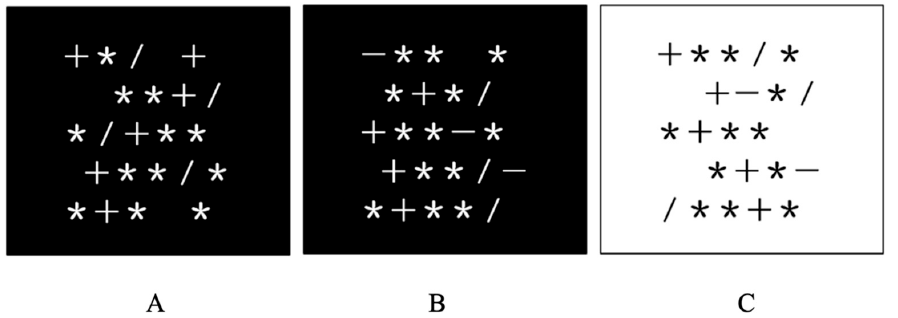
Figure 1. Illustration of the star counting task: ( A ) screen used in the first treatment level with only plus signs; ( B ) screen used in the second treatment level with both plus and minus signs; ( C ) screen used in the third treatment level with white background indicating the reversal of the meaning of plus and minus signs.